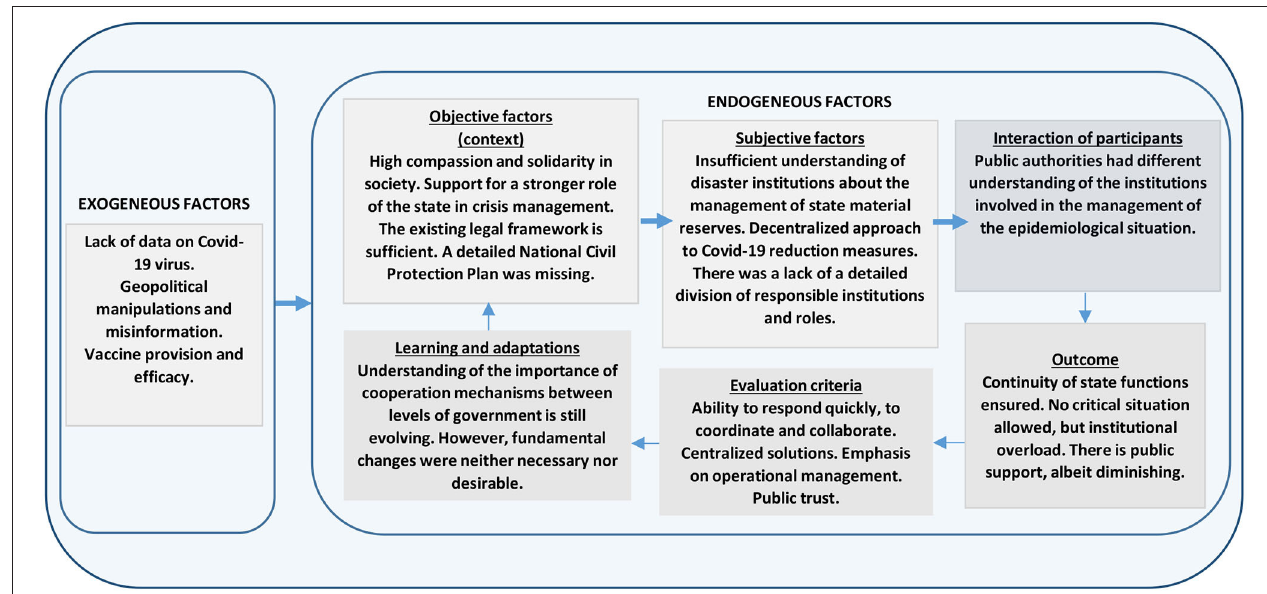
FIGURE 2 | The assessment of the effectiveness of the work of Latvian public administration during the COVID-19 pandemic crisis (5). Source: Authors’ analysis based on IAD framework.